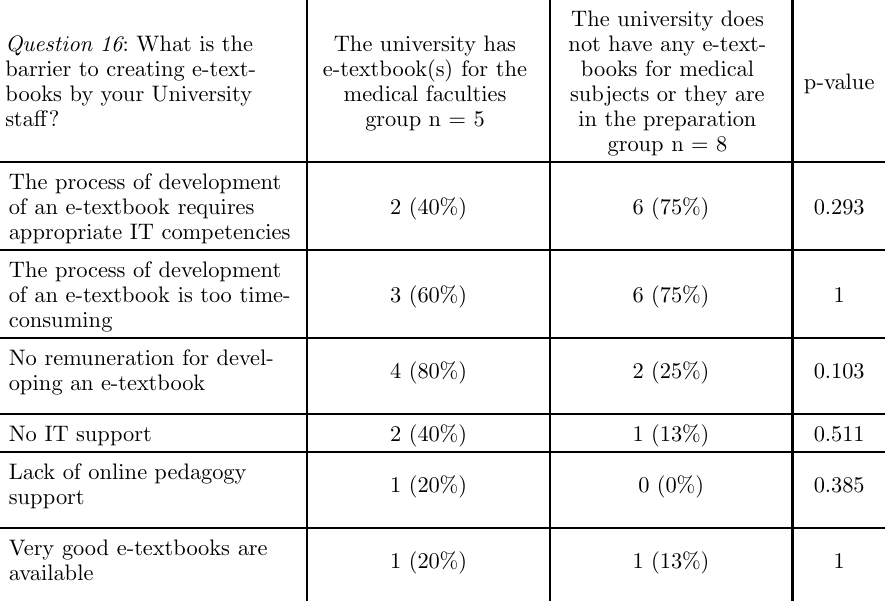
Question 16 : What is the barrier to creating e-text- books by your University